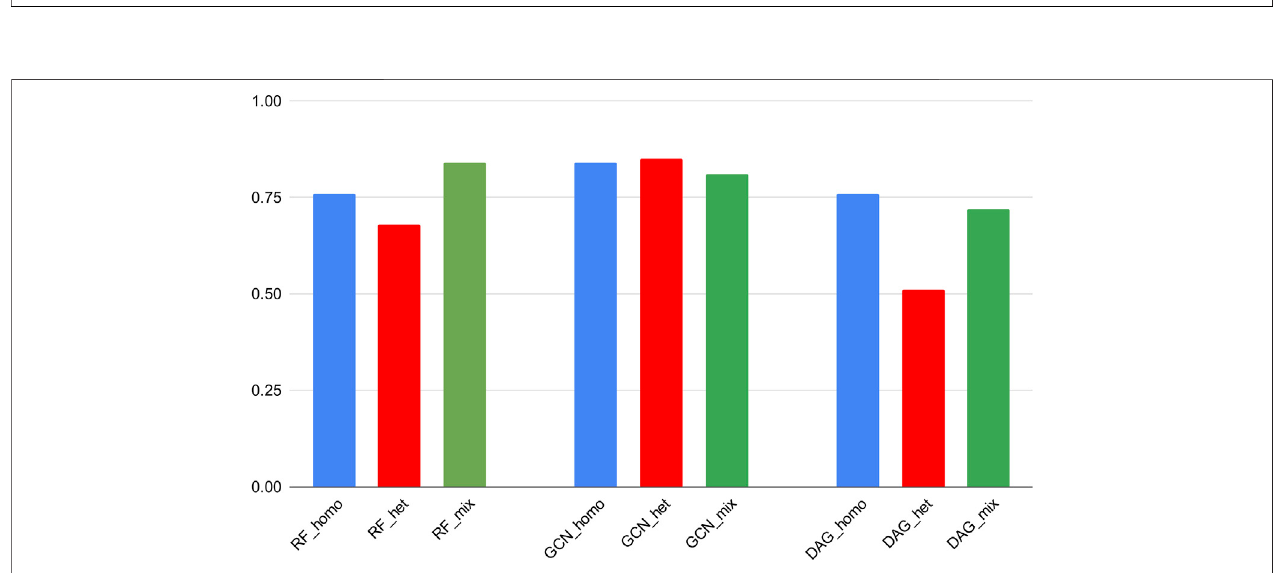
FIGURE 4 | ROC-AUC scores of the best classi fi ers tested on strati fi ed subsets of the data (homogeneous, heterogeneous, and mixed).